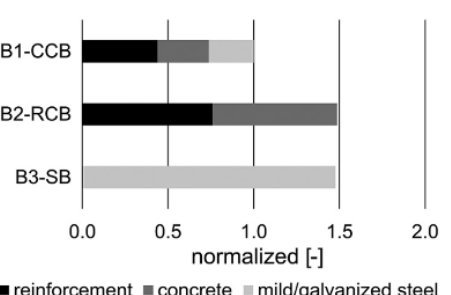
Figure 12. Comparison of the ADPf of various pedestrian bridge types (normalized values) divided by the used building materials, extracted from